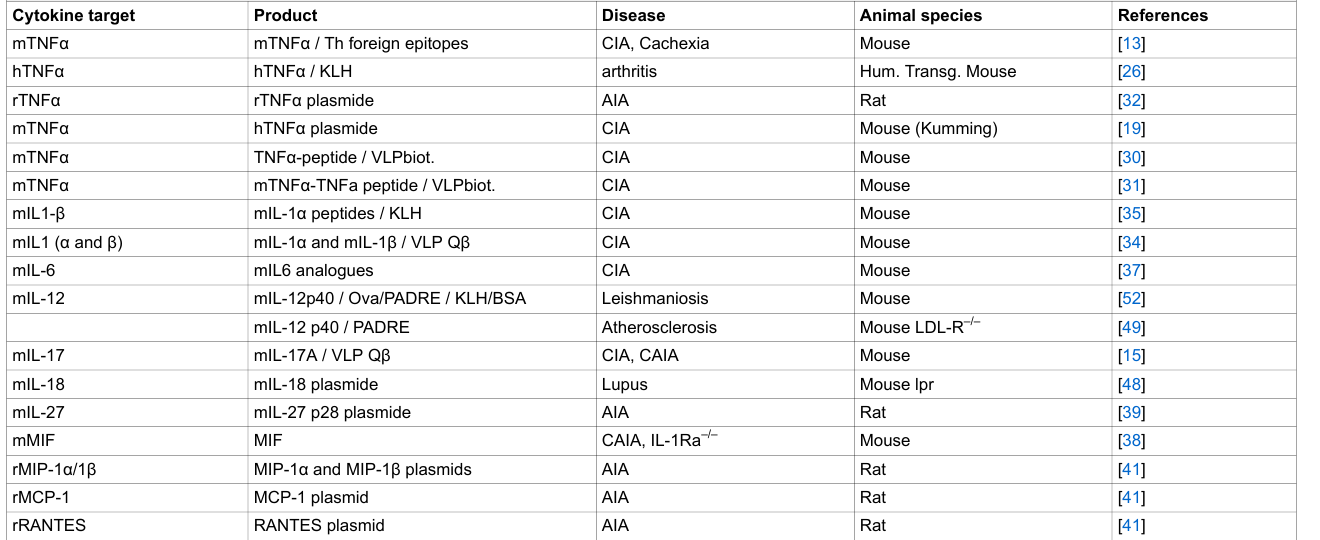
Table 1 Applications of anti-cytokine vaccinations in rheumatic diseases. Cytokine